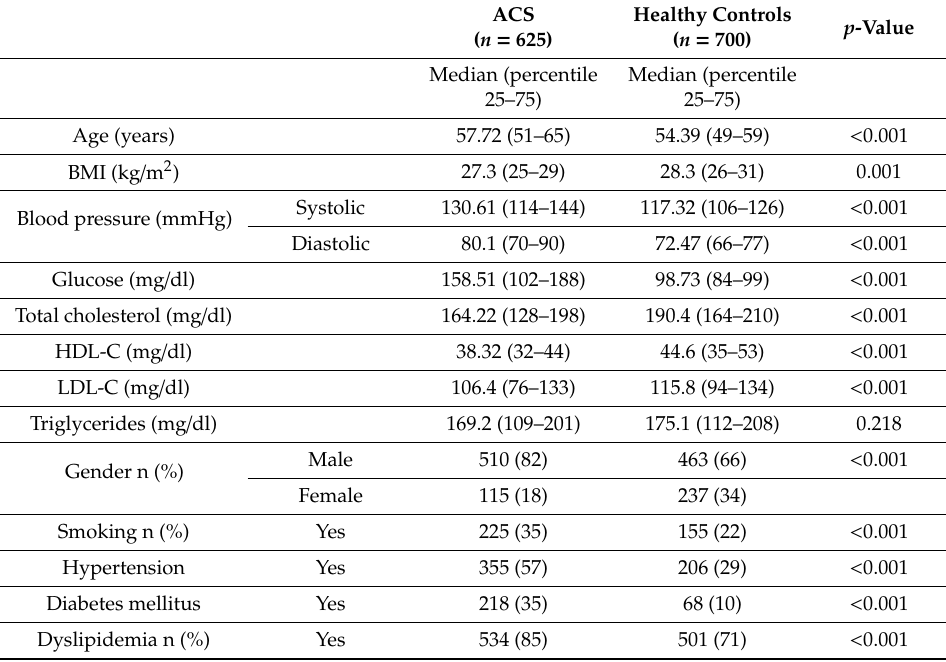
Table 1. Clinical characteristics and biochemical parameters of the study